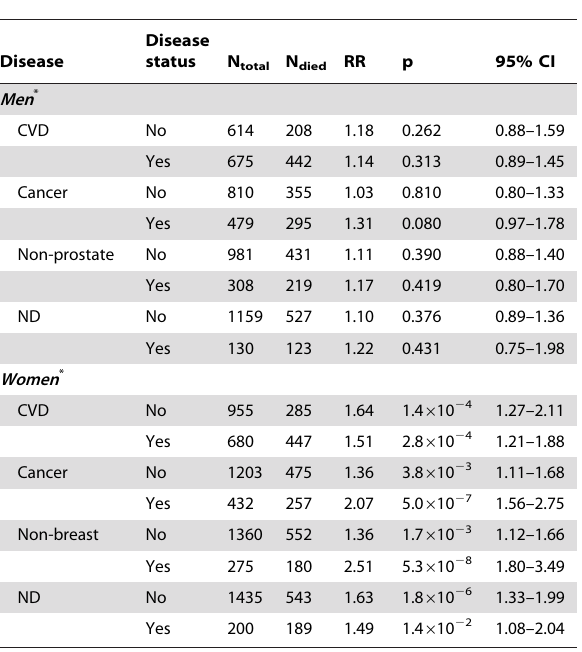
Table 3. Disease-stratified relative risks of death for the ApoE4 carriers compared to the non-carriers in the more homogeneous group of the FHS and FHSO participants with lifespans of 70 to 95 years.